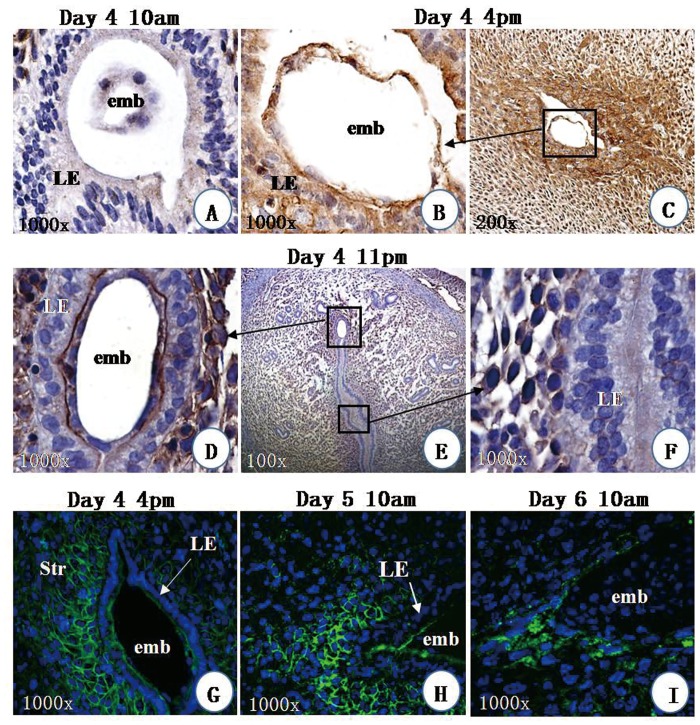
Expression of Axna2 at implantation sites.On Day 4 of pregnancy, the immunoreactivities (brown) at the implantation sites were weak at 10:00 am (A). The signal increased at 4:00 pm (B). At 4:00 pm, the signal was strong at the implantation sites (B) and in the nearby stroma (Str) (C). Concentration of signal was observed at the interface between the luminal epithelium (LE) and the embryo (emb) (D, E) but not between LE (F). Immunofluorescence staining showed that Axna2 immunoreactivies (green) were on the membrane of the endometrial stroma on Day 4 (G) and Day 5 (H) of pregnancy. The immunoreactivies became cytosolic on Day 6 of pregnancy (I).